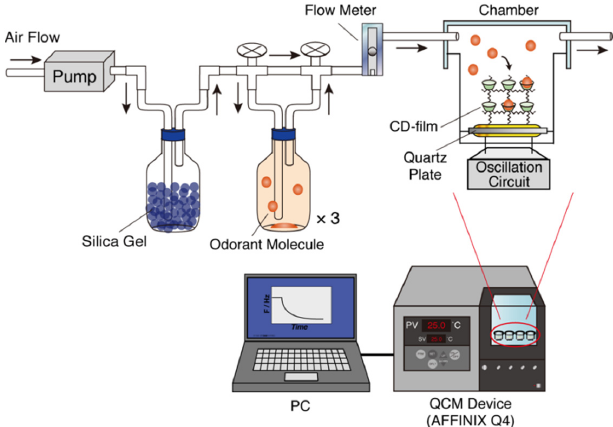
Figure 1. Schematic illustration of an airflow system combined with a quartz crystal microbalance (QCM) device modified with cyclodextrin (CD) films for odorant molecule detection.